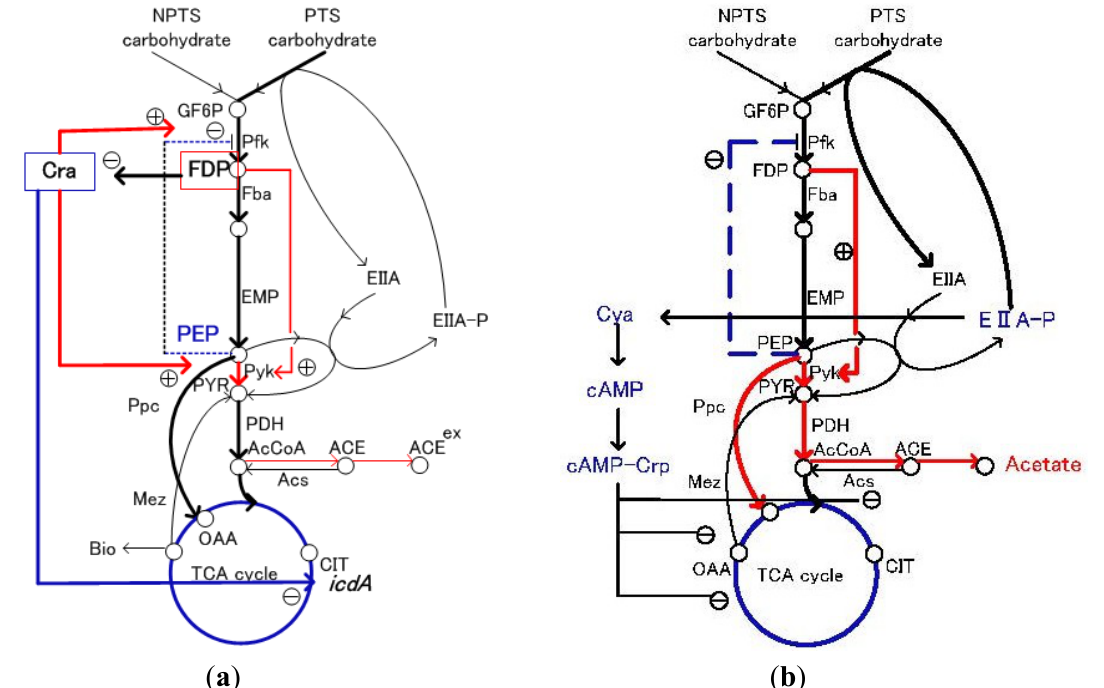
Figure 3. Feedforward and feedback controles by enzyme level and transcriptional regulations: ( a ) regulation by Cra, and ( b ) regulation by